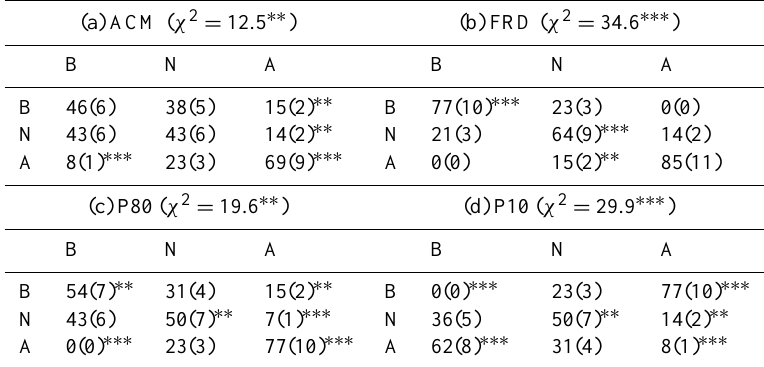
Table 2. Relative frequency (%) contingency tables between the mode 1 of July SST of each model (X mode 1, red lines in Fig. 6) and the normalized difference of Ni˜no3 and AMO indexes. In parentheses are the absolute frequency values. Categories are Below (B), Normal (N) and Above (A). Levels of significance are represented by *** > 99% ( α < 1%), ** 95–99% (1 <α < 5%) and * 90–95% (5 <α < 10%).